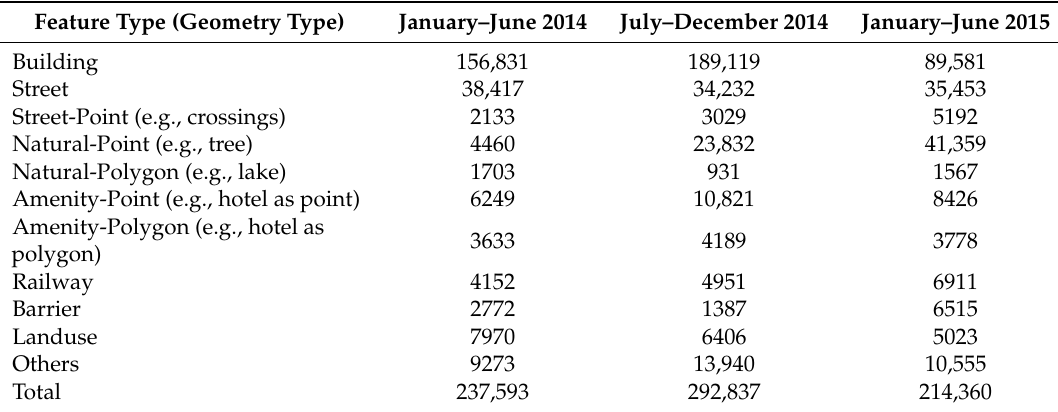
Table 7. Number of actions per feature type and six-month periods in